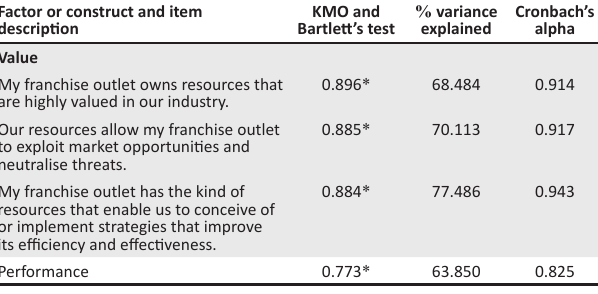
TABLE 1: Summary of factor analysis on five